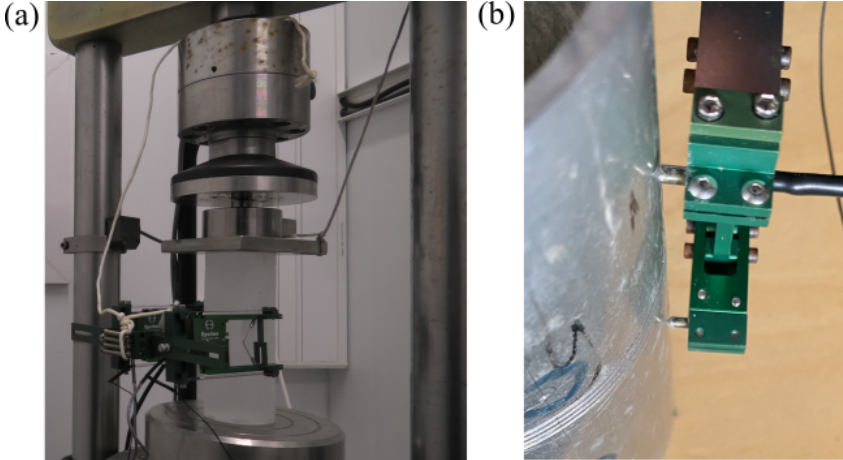
Figure B3. (a) Overview of uniaxial compression test. (b) Mounting of strain sensor on a sample.